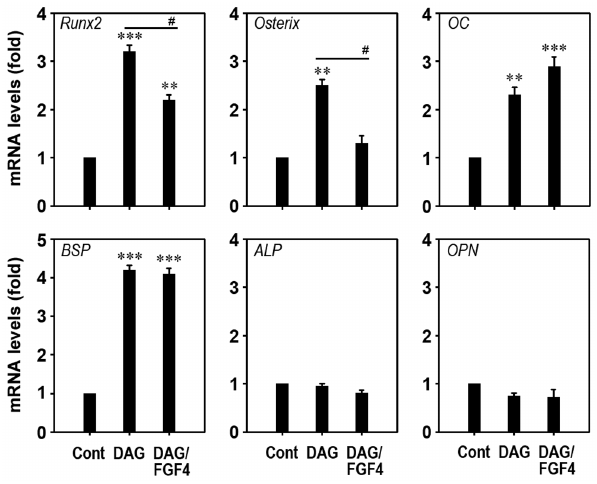
Figure 7. Addition of FGF4 diminishes DAG-induced expres- sion of Runx2 and osterix in mESCs. Cells were incubated in the presence or absence of DAG and 50 ng/ml FGF4 for 24 h, and expression patterns of bone-specific genes were analyzed by real-time RT-PCR. **p , 0.01 and ***p , 0.001 vs. untreated control cells. # p , 0.05 vs. cells treated with DAG